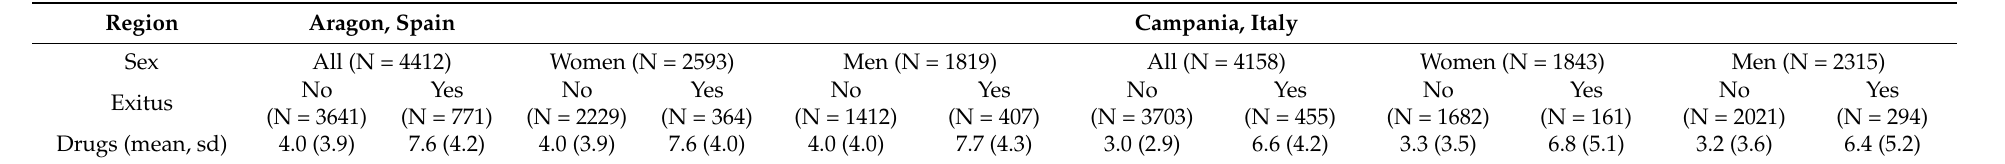
Table 2. Number of drugs dispensed of the study population, by region and follow-up status (i.e., exitus no/yes).